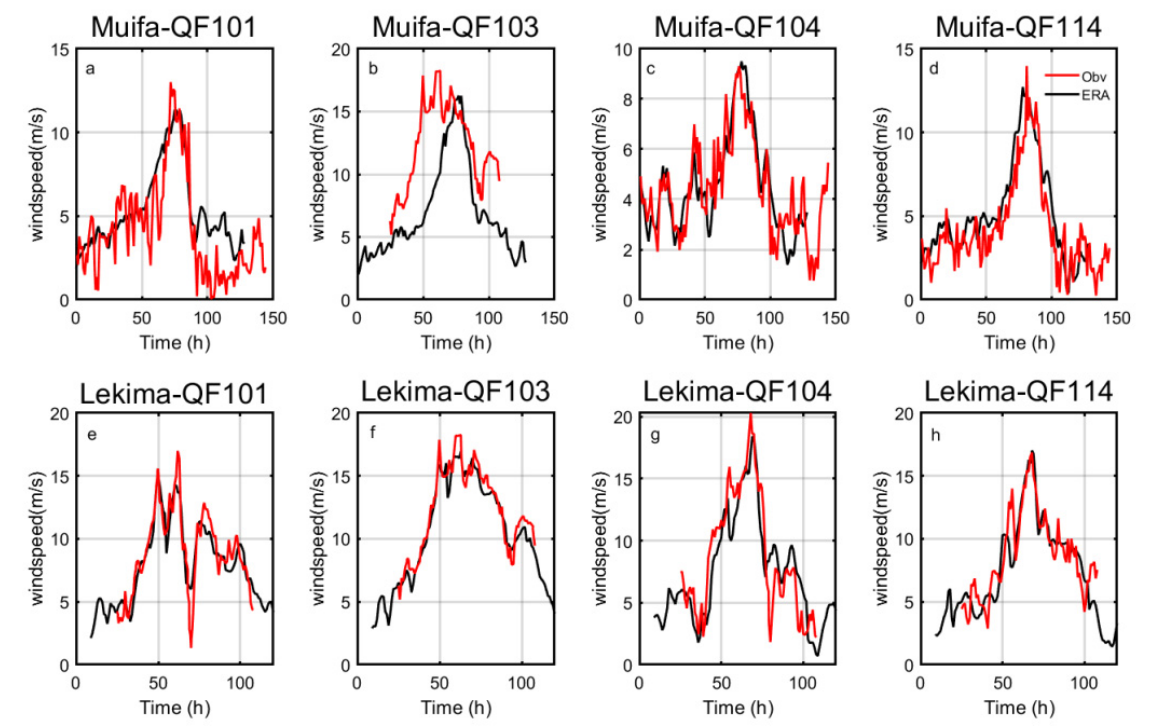
Figure 3. Landforms of the Northern East China Sea. Locations of buoys (QF101, QF103, QF104, and QF104) and stations (HHG, WFG, LKO, WMT, and RZH) are marked.